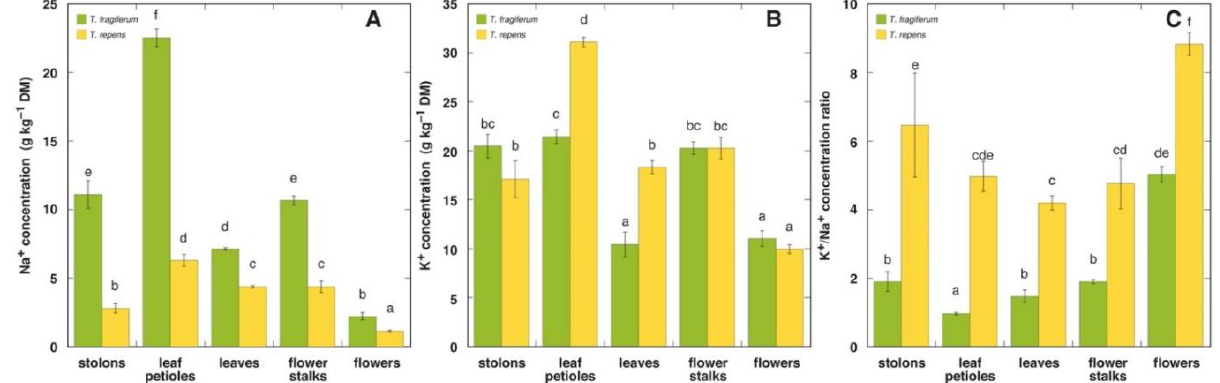
Figure 1. Na + ( A ) and K + ( B ) concentration, and K + /Na + concentration ratio ( C ) in different parts of coexisting T. fragiferum and T. repens plants in field conditions of a salt-affected wetland. Different letters indicate significant differences between the treatments ( p < 0.05).